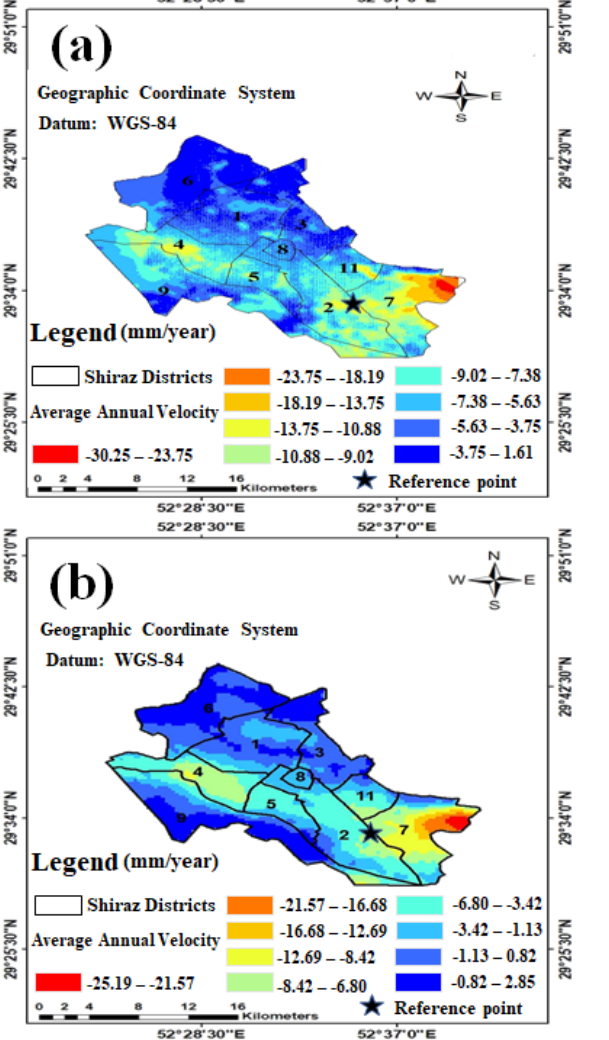
Figure 4. The average annual velocity of the subsidence in 10 districts of Shiraz, is derived from the descending (a) and ascending (b) orbits; The reference point coordinate is 29.5516, 52.166 .